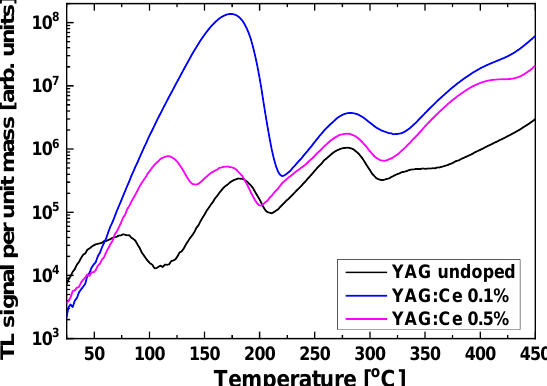
Figure 5. TL glow-curves of the studied YAG:Ce crystals. Dose 2 Gy.